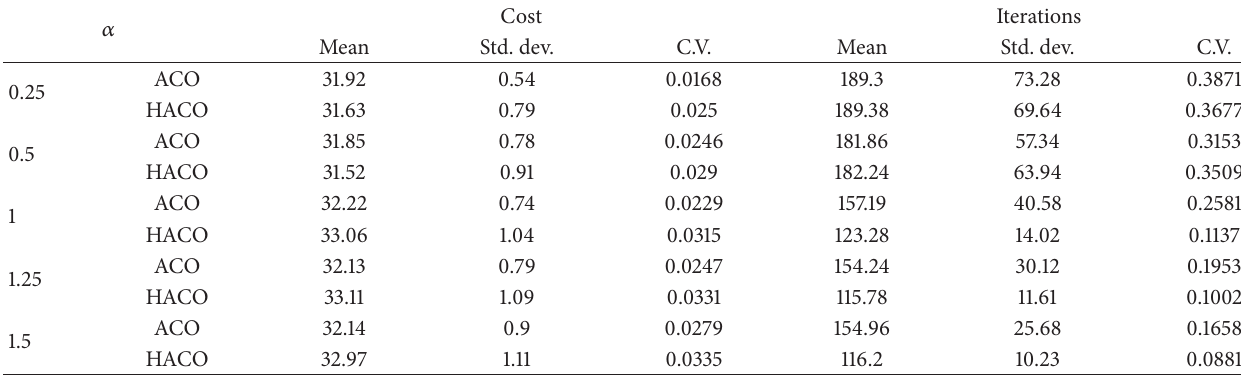
Table 2: Results with different 𝛼 (cost: million CNY; iterations: times).